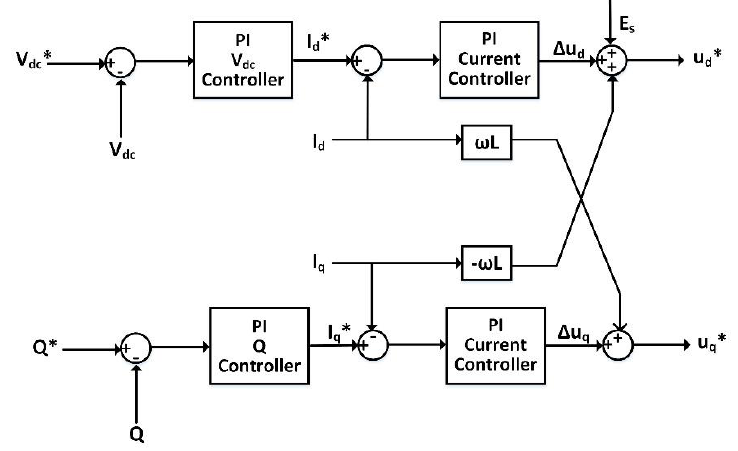
Figure 6. The control diagram of the DC-AC inverter. Reprint with permission [29]; 2020, IEEE.